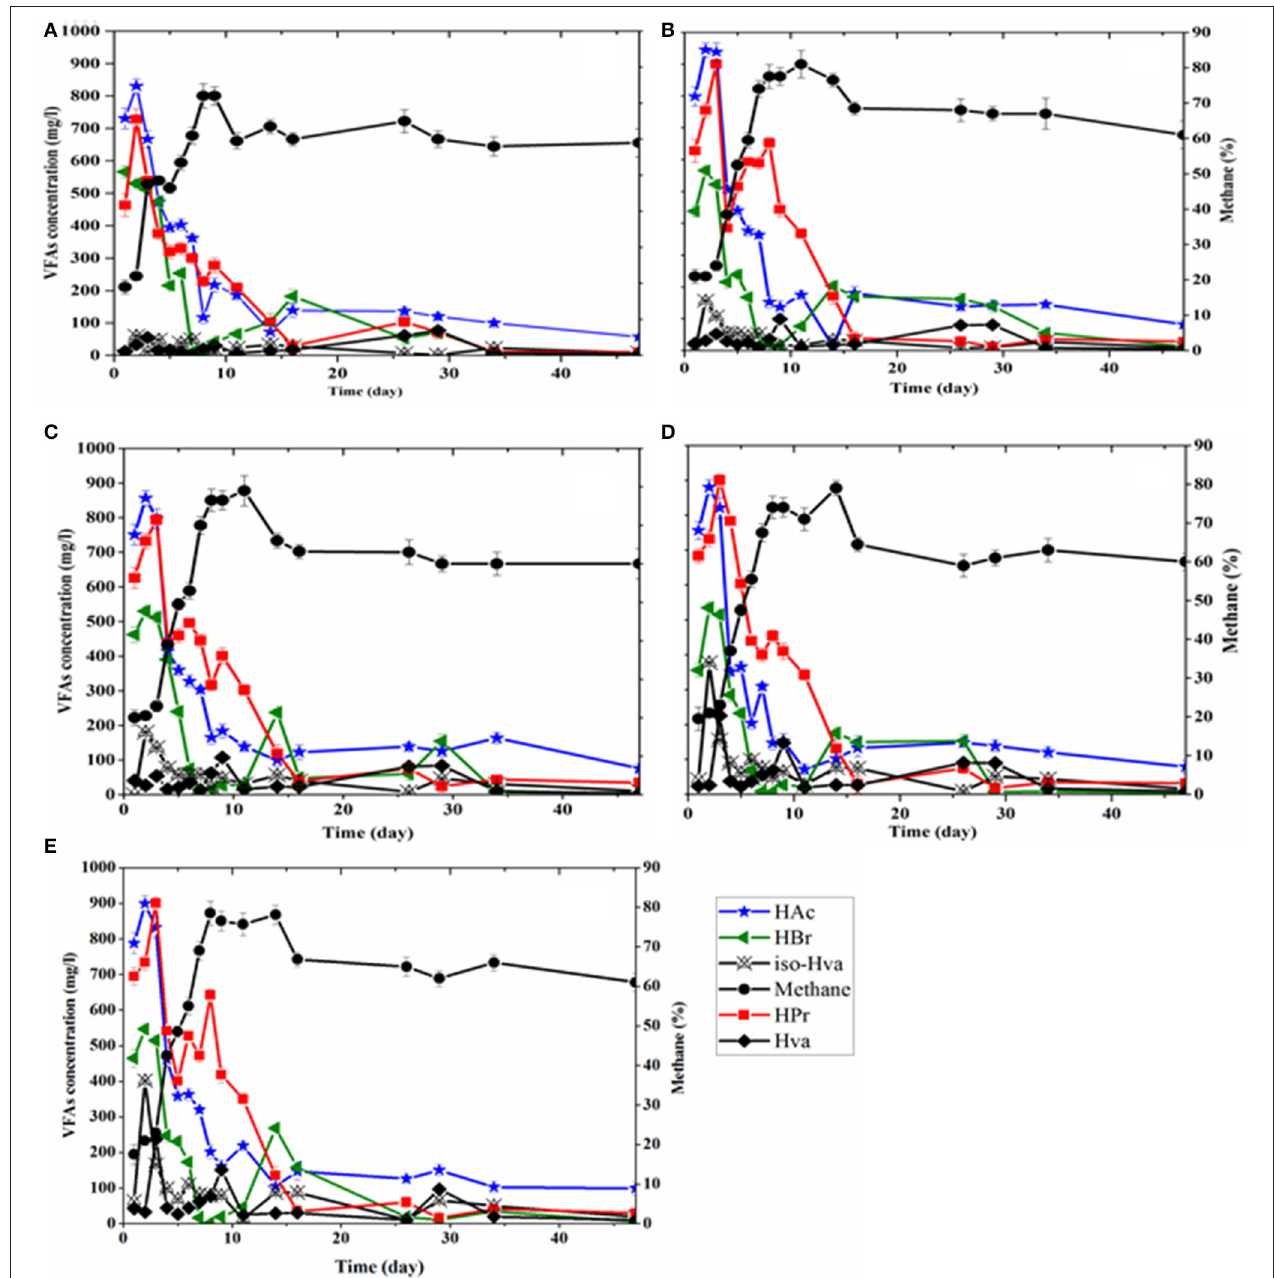
FIGURE 5 | Methane concentration and VFAs production pattern as a function of digestion time: (A) control, and TP at (B) 80 ◦ C, (C) 100 ◦ C, (D) 120 ◦ C, and (E) 140 ◦ C.